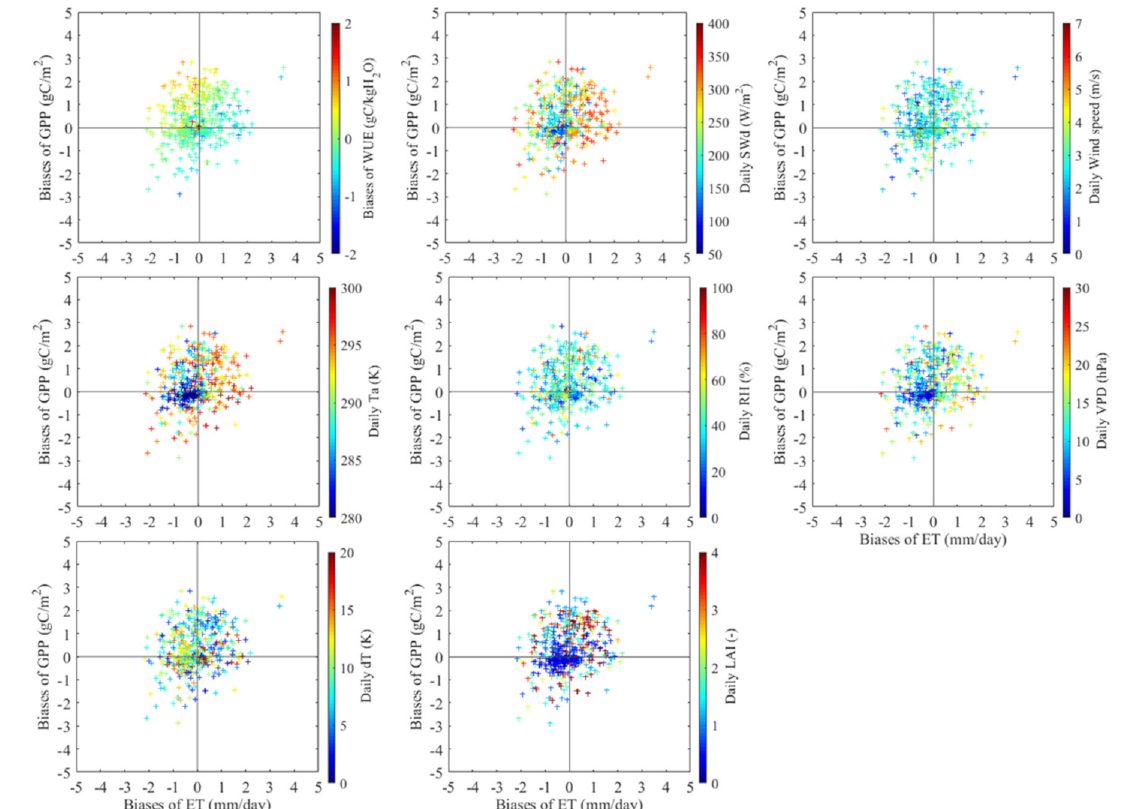
Figure 5. Scatterplots of daily GPP and ET biases with daily